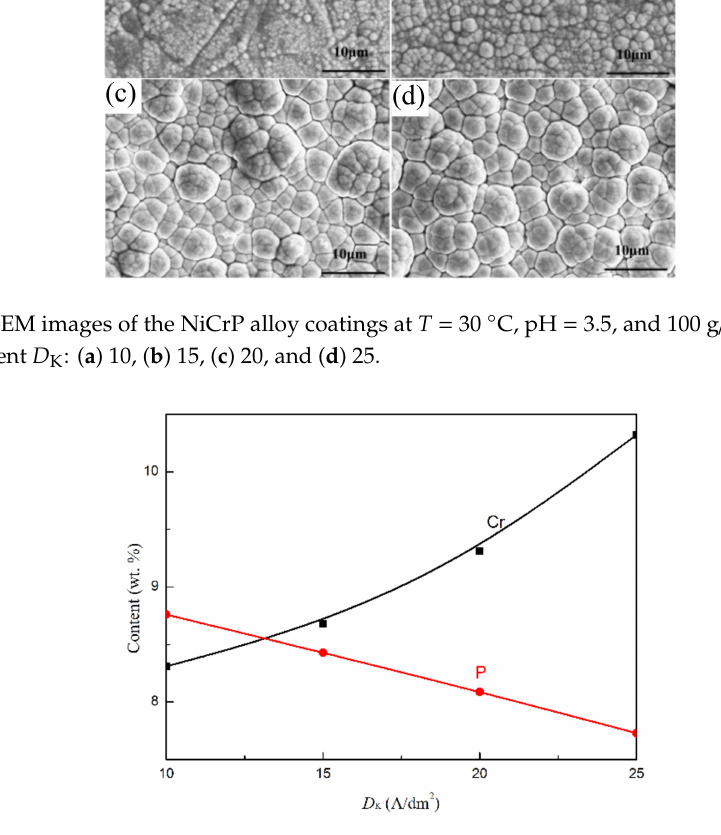
Figure 6. Relationship between the D K and composition of the alloy